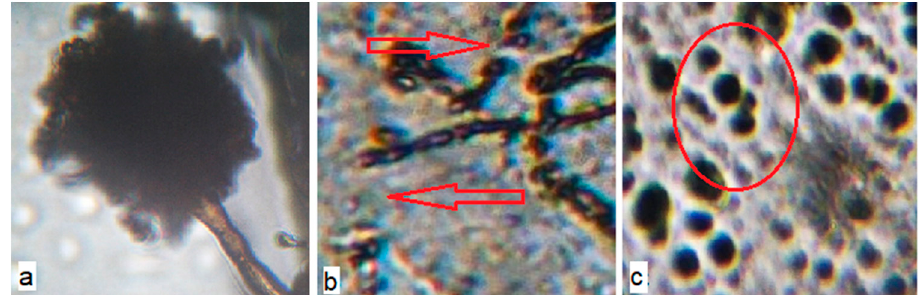
Figure 9. Microphotographs of the surface of the inoculated polyethylene (PE) materials with birch bark extract (BBE) and with the use of ultrasonic treatment on the 14th day of the exposure of A. niger (400 × magnification): ( a ) PE 0% BBE, ultrasound; ( b ) PE 0.5% BBE, ultrasound; ( c ) PE 2.0% BBE, ultrasound.